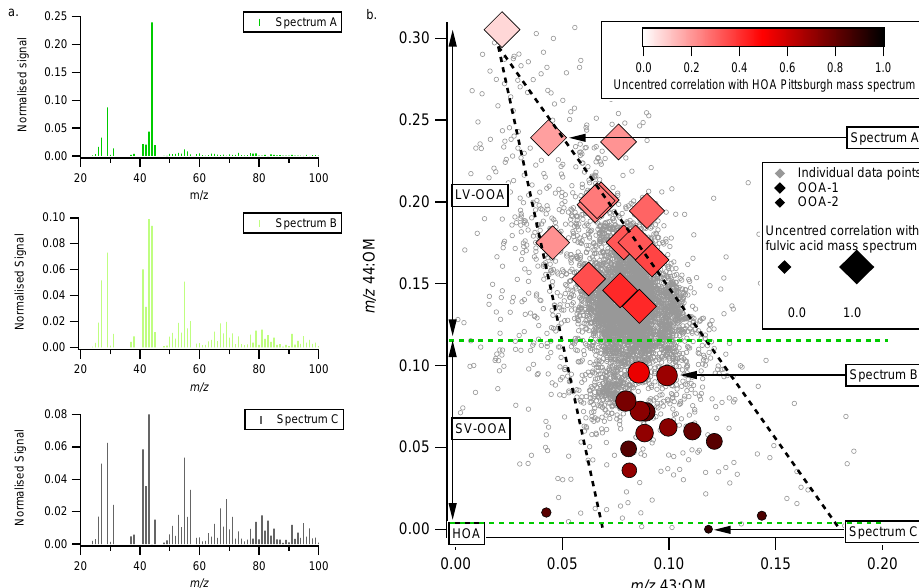
Fig. 5. (a) Examples of mass spectra derived from the PMF analysis. (b) Relationship between the fractional signal at m/z 44 normalised to the total organic loading and m/z 43 normalised to the total organic loading. Grey markers refer to individual data points from all of the flights. Diamond and circle markers denote the same measures from the high and low oxygenated factors (OOA-1 and OOA-2) identified from the PMF analysis, coloured and sized according to their correlation with Pittsburgh HOA and laboratory derived fulvic acid respectively. The mass spectra shown in (a) are identified on (b) by the arrow and text box. The thick dashed black lines refer to guidelines from Ng et al. (2009) discussed in the main text. The dashed green lines refer to guideline bounds for the different PMF clusters identified as LV-OOA, SV-OOA and